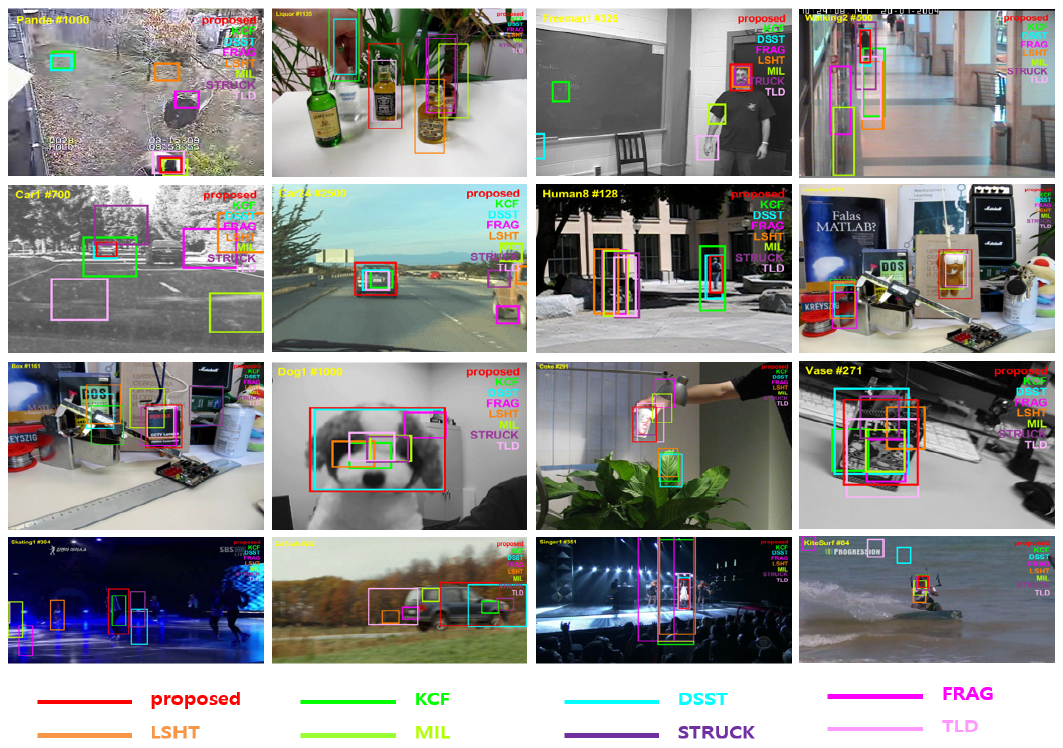
Figure 8. The experimental results comparison of the proposed tracker and existing